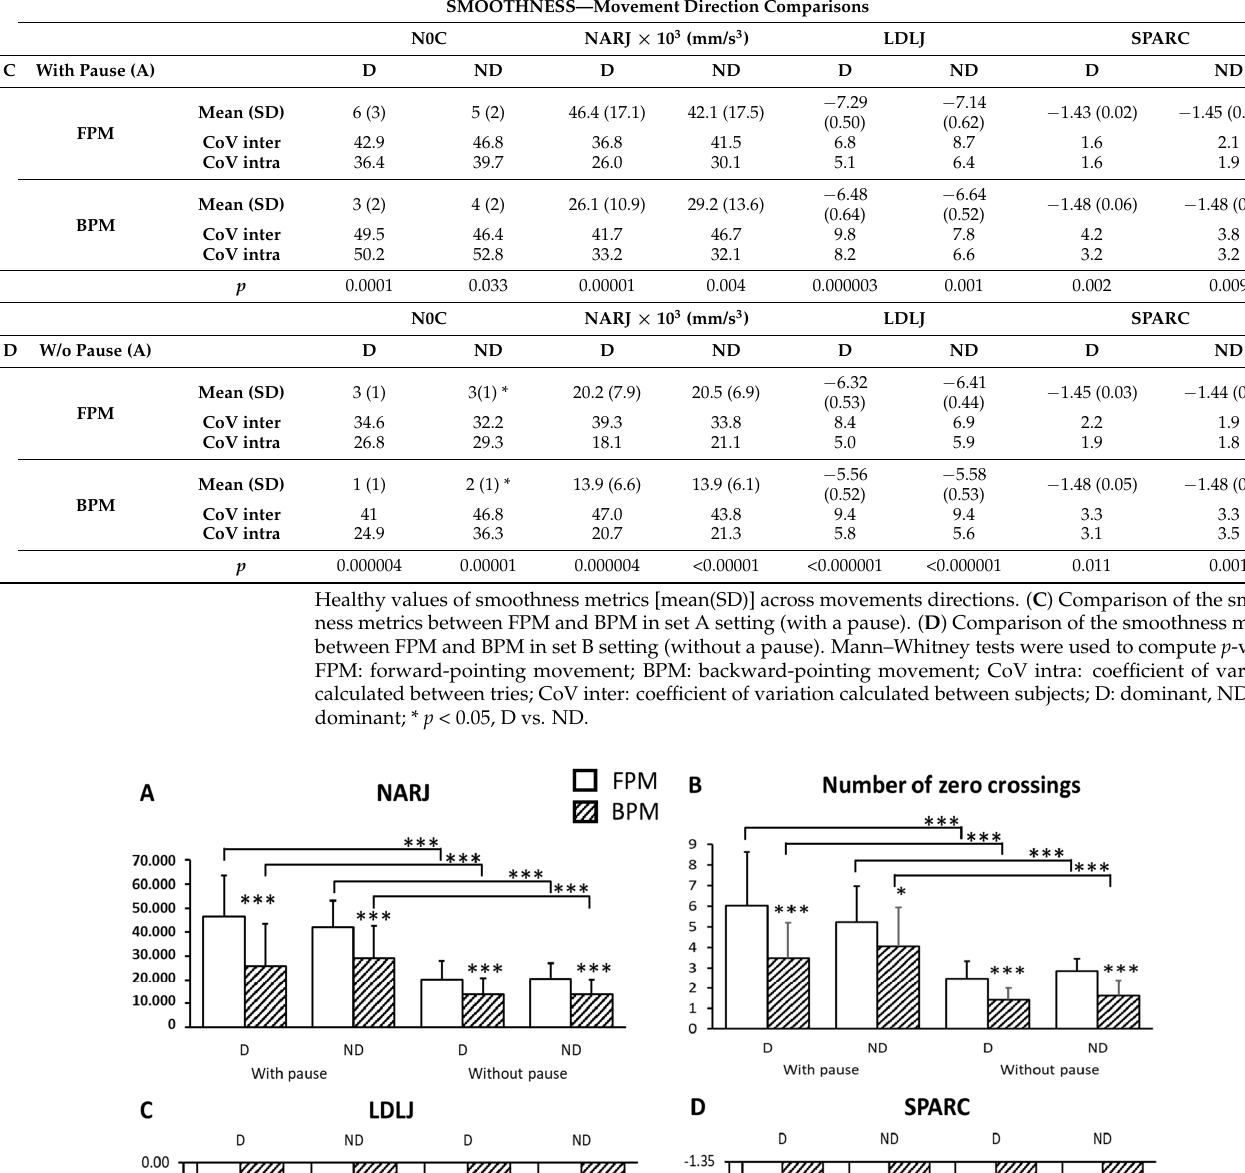
Table 4. Movement direction comparisons across sets.